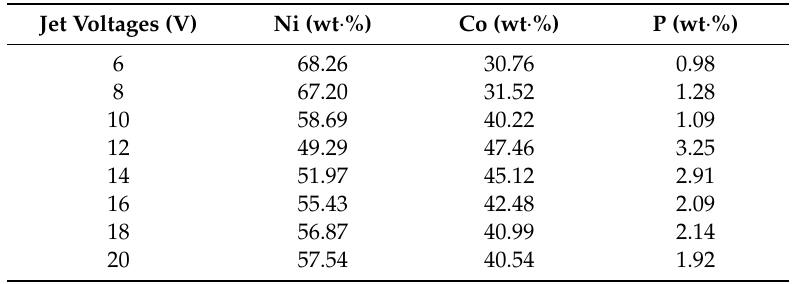
Table 4. E ff ect of jet voltages on element content of Ni–Co–P alloy coatings.